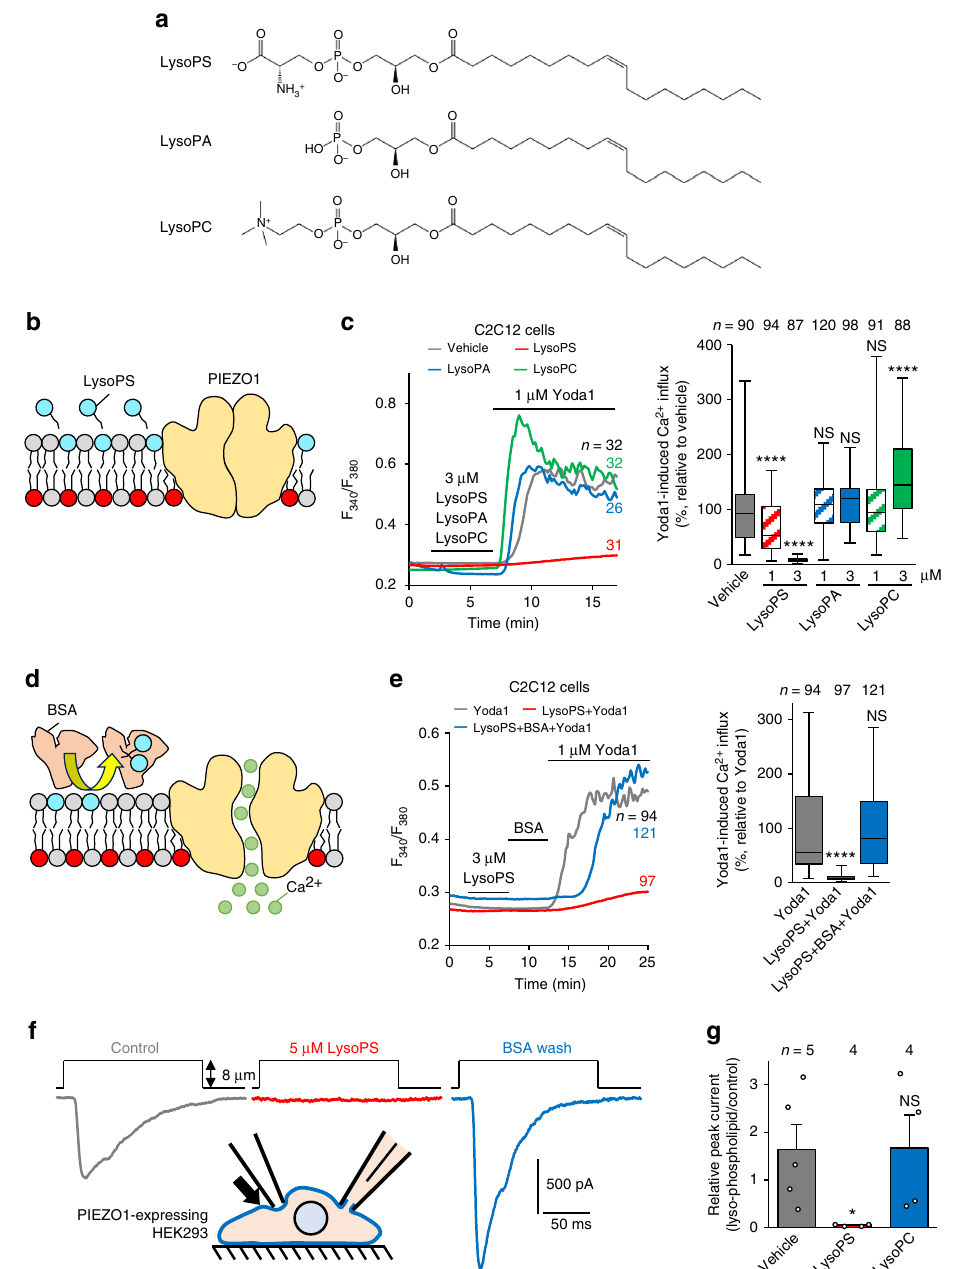
Fig. 6 Suppression of PIEZO1 activation by cell surface-inserted LysoPS. a Chemical structures of LysoPS, LysoPA and LysoPC. b – d Suppression of agonist- induced PIEZO1 activation by cell-surface LysoPS. b Schematic model showing suppression of PIEZO1 activation by insertion of LysoPS to the cell surface. c Representative traces (left) and quanti fi cation (right) of Yoda1-induced Ca 2 + in fl ux in WT C2C12 myoblasts treated with vehicle, LysoPS, LysoPA or LysoPC. d Schematic model showing restoration of PIEZO1 activation by removal of cell surface-inserted LysoPS with lipid-free BSA. e Representative traces (left) and quanti fi cation (right) of Yoda1-induced Ca 2 + in fl ux in WT C2C12 myoblasts treated with LysoPS and washed with lipid-free BSA. f , g Impairment of mechanical stimulation-induced PIEZO1 activation by cell-surface LysoPS. f Representative traces of the mechanically-activated current evoked by indentation (8 μ m) using a glass probe in PIEZO1-expressing HEK293 cells before (grey, control) and during administration of 5 μ M LysoPS (red), followed by removal of LysoPS with lipid-free BSA (blue). g Relative peak currents induced by mechanical stimulation before (control) and during administration of vehicle (grey), 5 μ M LysoPS (red), and 5 μ M LysoPC (blue) in f . * P < 0.05 and **** P < 0.0001 (Student ’ s t -test). NS not signi fi cant, n sample number. Bar graphs represent mean± S.E.M. Box and whiskers graph ― line: median, box: upper and lower quartiles, whiskers: maxima and